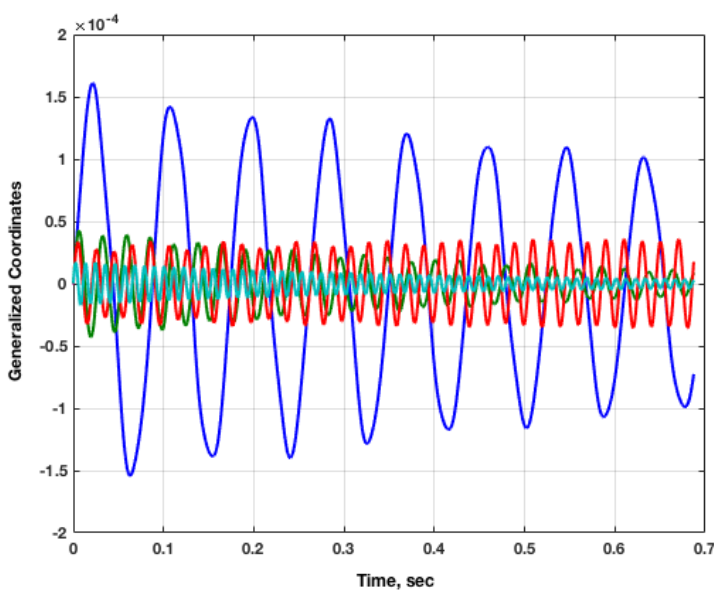
Figure 19. FUN3D full solution generalized coordinates at M = 1.141, Q = 30 psf, inviscid solution. Mode 1 = blue, Mode 2 = green, Mode 3 = red, Mode 4 = cyan.